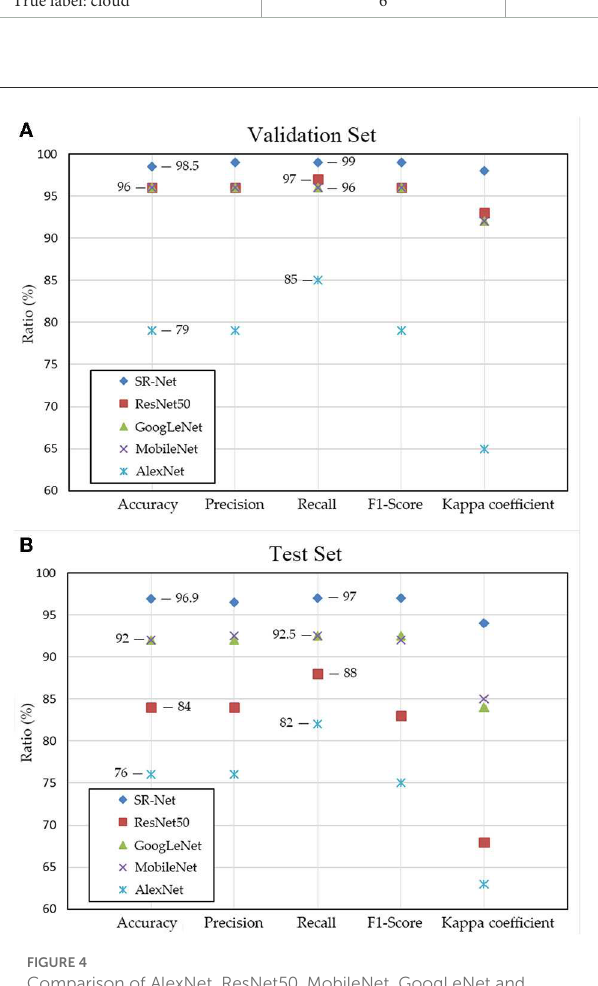
FIGURE4 Comparison of AlexNet, ResNet50, MobileNet, GoogLeNet and SR-Net models for each evaluation indices based on validation set (A) and test set (B) .